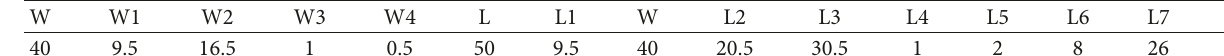
Figure 2: Layout of the proposed binary tree fractal antenna. Table 1: Dimensional of the proposed antenna.